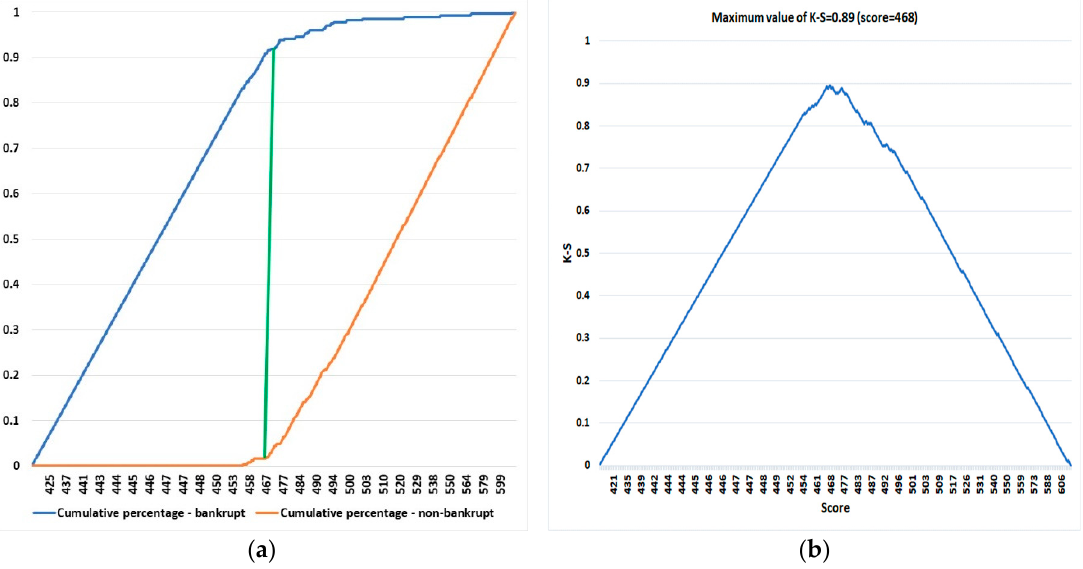
Figure 11. Interpretation of the Kolmogorov-Smirnov validation statistic for the LDA model and the test and validation sample: ( a ) Difference in cumulative distribution function for both classes relative to score; ( b ) Relationship of KS as the maximum difference between cumulative distribution functions for both classes relative to score. Source: own elaboration using Excel.